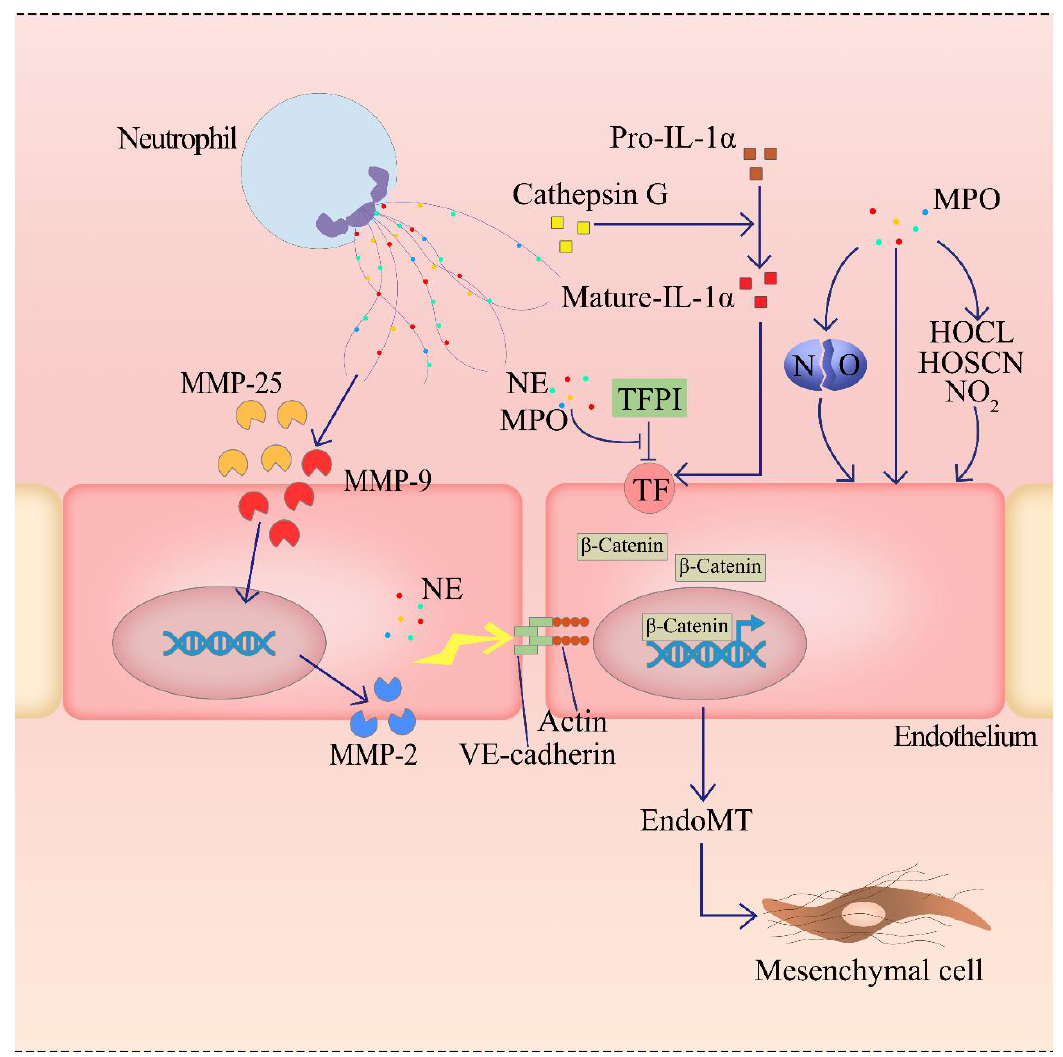
Figure 3. The metalloproteinase-9 (MMP-9) (may together with MMP-25) released after the produc- tion of NETs will interact with ECs, causing ECs to produce MMP-2. MMP-2 and NE from NETs to attack the junction structures between ECs—VE-cadherin, E-cadherin and actin, resulting in damage to the physiological structure of ECs. Meanwhile, net-induced β -catenin nuclear translocation induces Endothelial-to-Mesenchymal Transition (EndoMT) in ECs, which can be exacerbated by impaired VE-cadherin. In addition, neutrophil elastase (NE) and myeloperoxidase (MPO) were released by NETosis to destroy tissue factor pathway inhibitor (TFPI). By inhibiting the decomposition of TF, the expression level of TF was increased, and the endothelium was damaged by increasing blood viscosity. MPO derived from NETs directly destruct ECs by breaking NO, oxidants (HOCI, HOSCN, and NO 2 ) production and non-catalytic pathway. Moreover, Cathepsin G cleaves the pro-IL-1 α precursor into interleukin-1 α (IL-1 α ) and further acts on